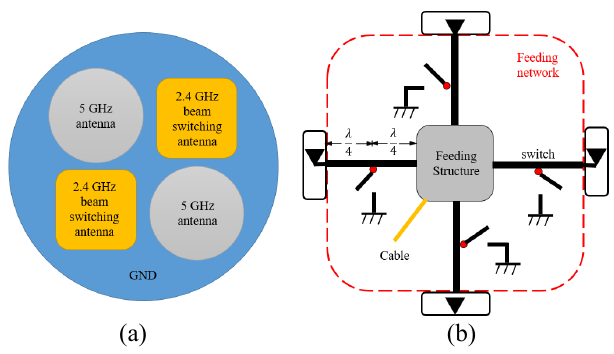
Figure 2: Structures of the proposed dual-band MIMO antenna: (a) antenna system and (b) antenna cell diagram for the 2.45-GHz antenna.